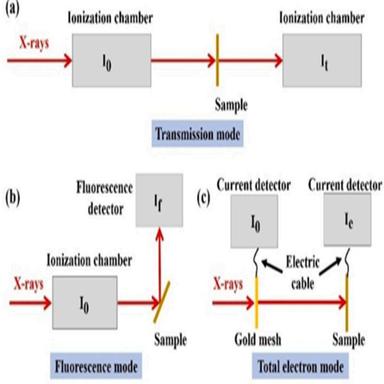
Schematic illustration of the XAS experiment setup in (a) Transmission mode, (b) Fluorescence mode, and (c) Total electron yield mode .